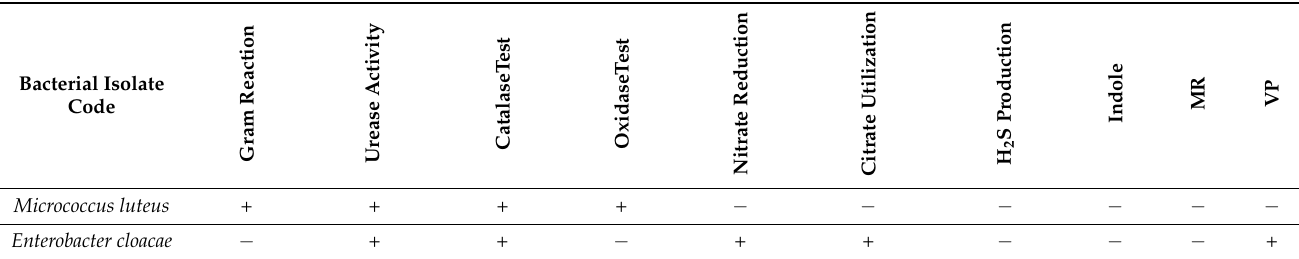
Table 3. Morphological and biochemical characteristics of the most potent plant growth-promoting endophytic bacterial isolate.